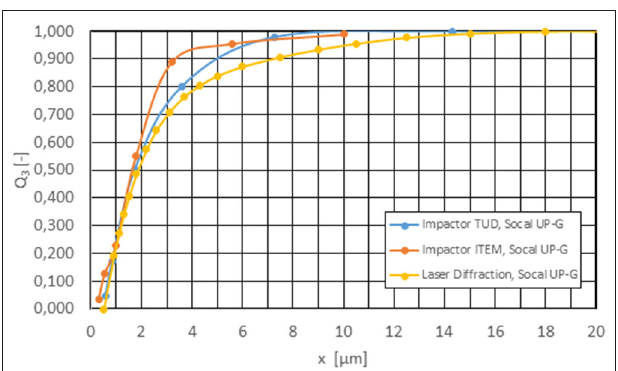
FIGURE 3 | Comparison cascade impactor—laser diffraction for calcium carbonate after 3h 30min test duration; c m = 500 mg/m 3 , ρ eff = 1,000 kg/m 3 .